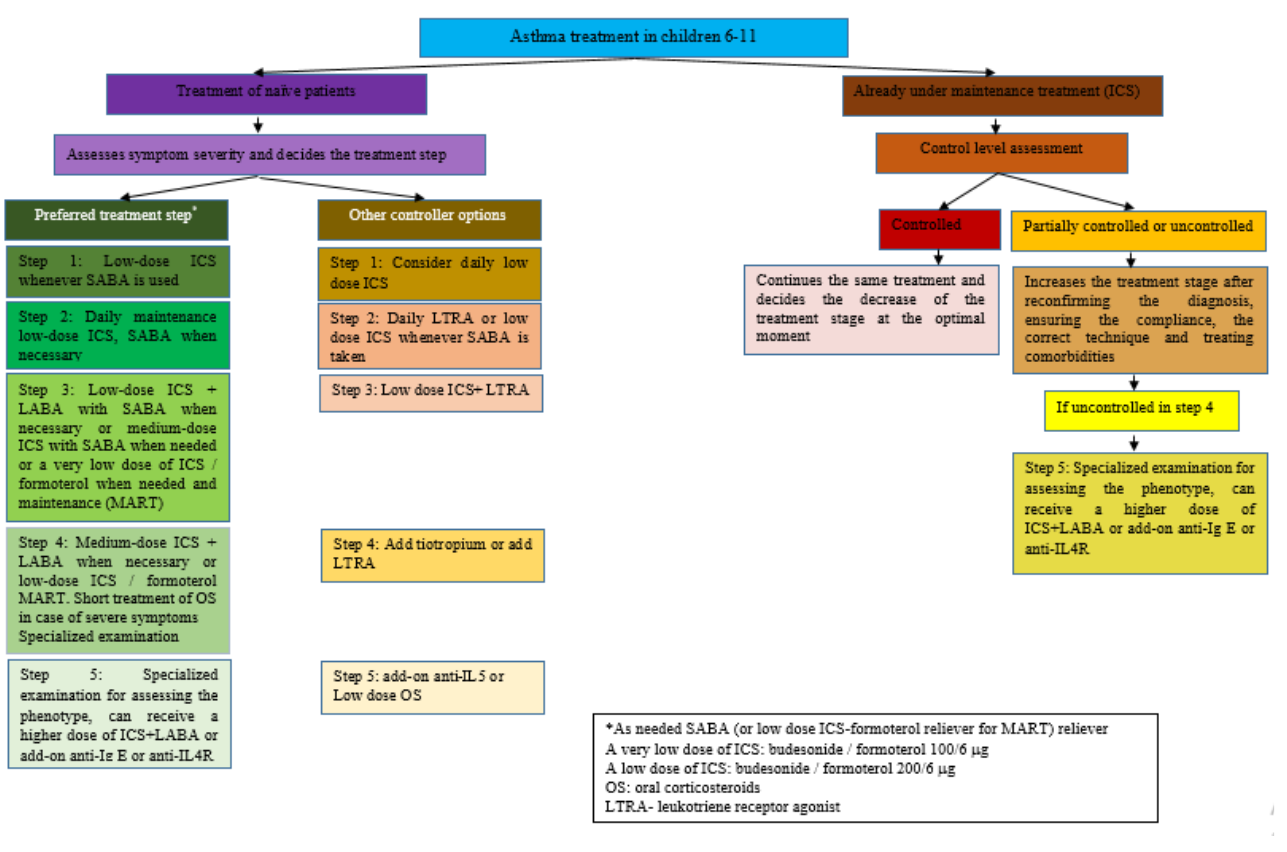
Figure 1. Asthma treatment based on GINA 2022 recommendations for children aged 6–11 [6] and adapted from Recent Advances in Long-Term Management of Asthma (published online ahead of print, 20 January 2022). Indian J Pediatr. 2022 [42].